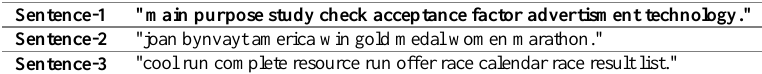
Table 4. Segmentation of text into its sentences.